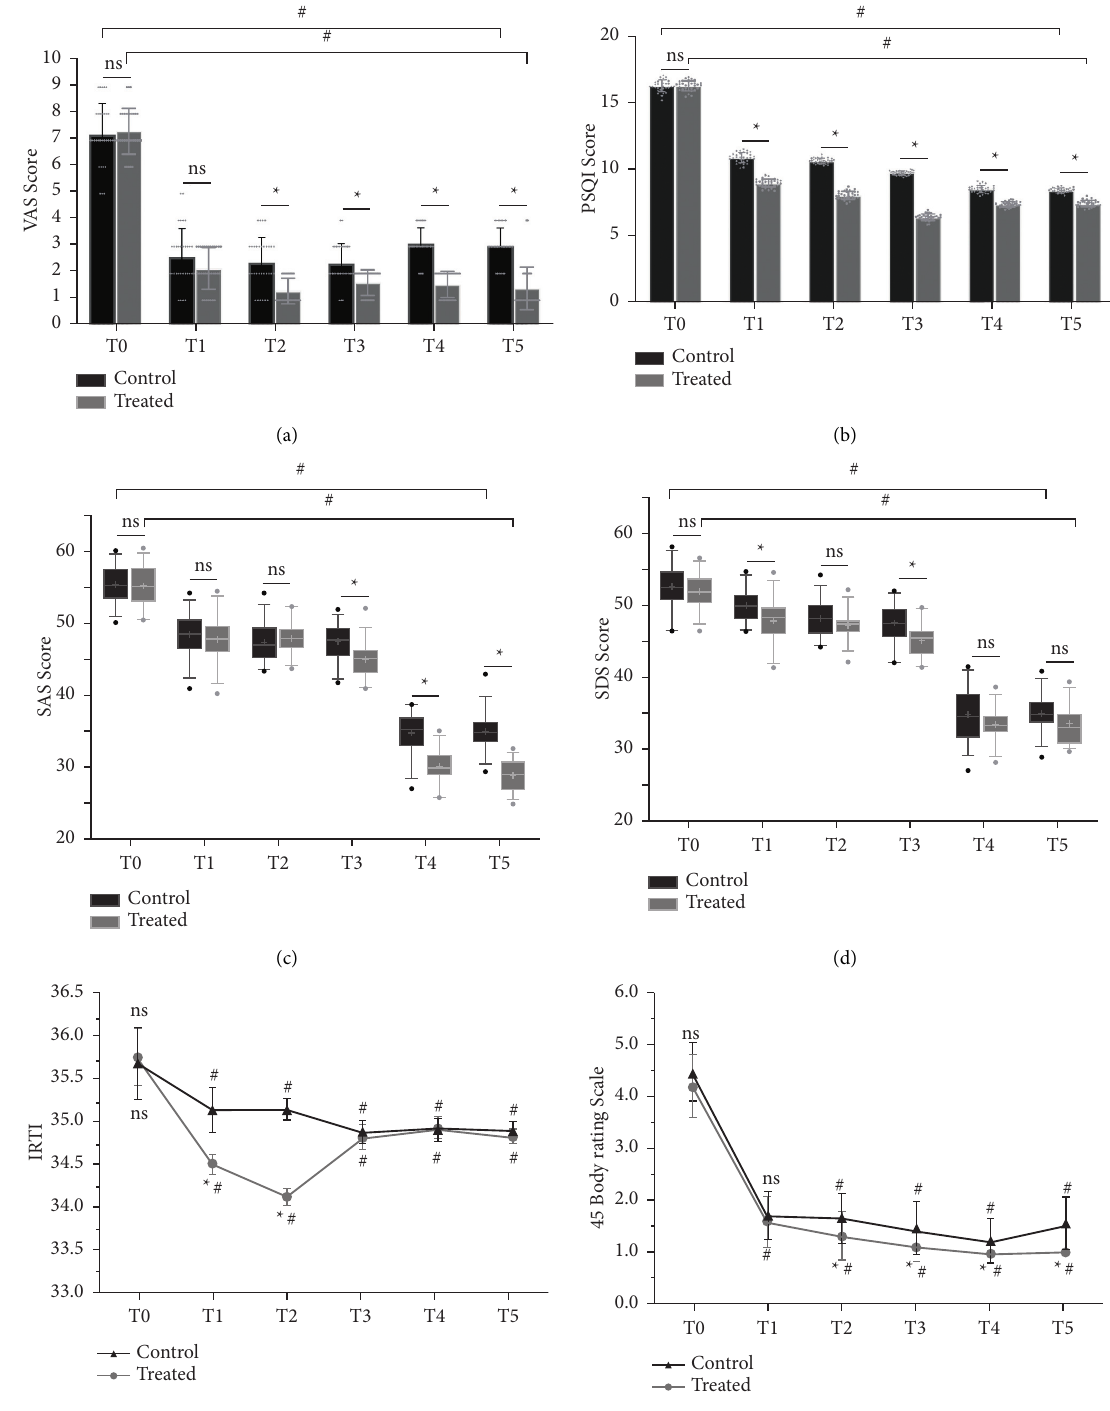
Figure 4: (a–f) Comparison of clinic scores at different time point of before and after PRF in the two groups. Control (PRF+NS) and treated (PRF+lidocaine); PRF � pulsed radiofrequency; NS � normal saline. Results are presented as mean ± SD. Compared to group control at a simultaneous point, ∗ P < 0 . 05. The treatment group was compared to before surgery, # P < 0 .